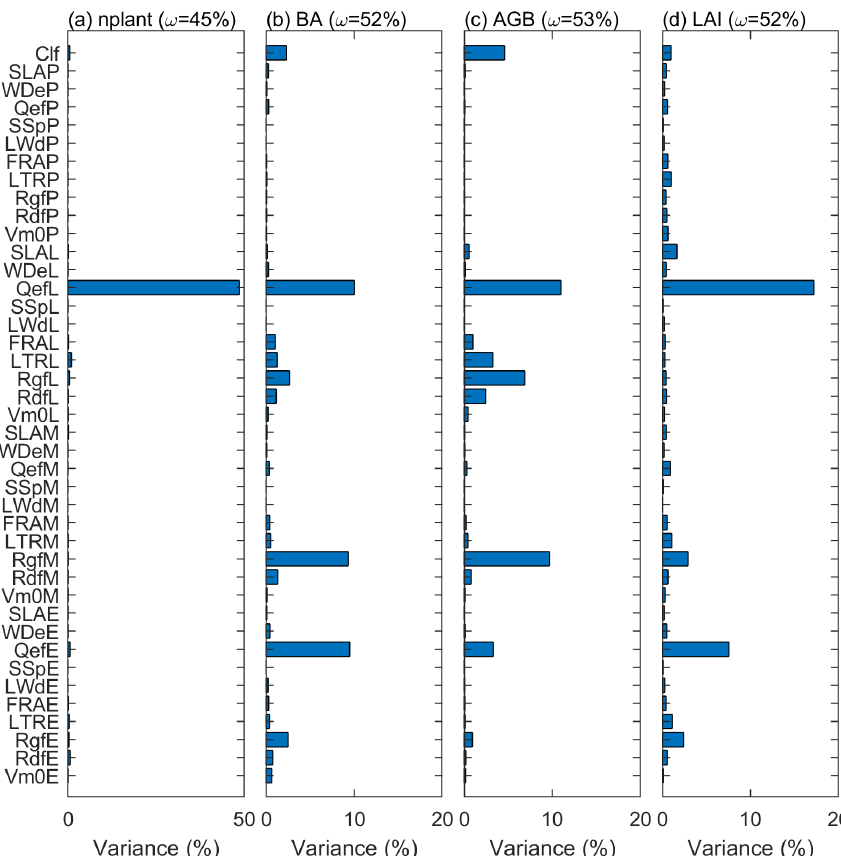
Figure 9. The variance explained by each parameter for variables (a) stem density, (b) basal area, (c) aboveground biomass, and (d) leaf area index. The variance explained by the interaction among parameters are given in